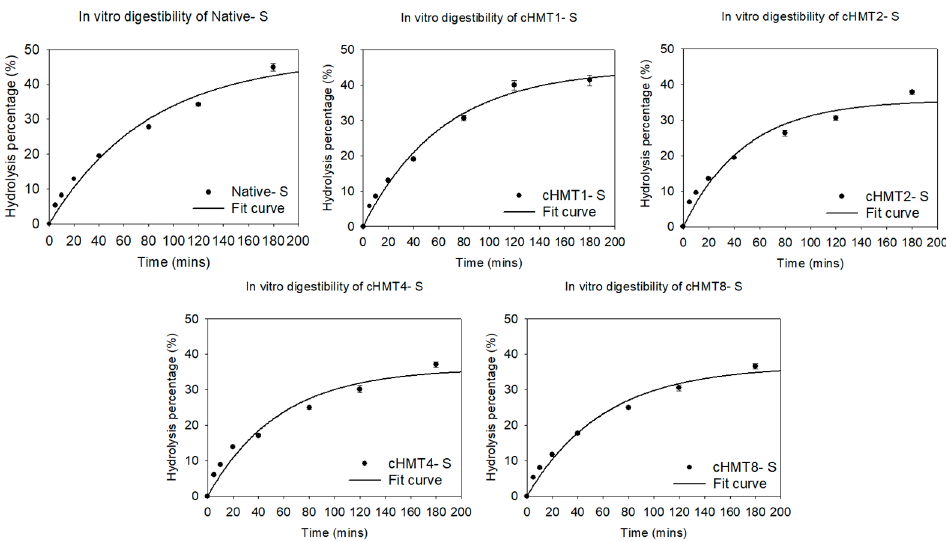
Figure 4. The hydrolysis curve of native and cHMT water caltrop starch.